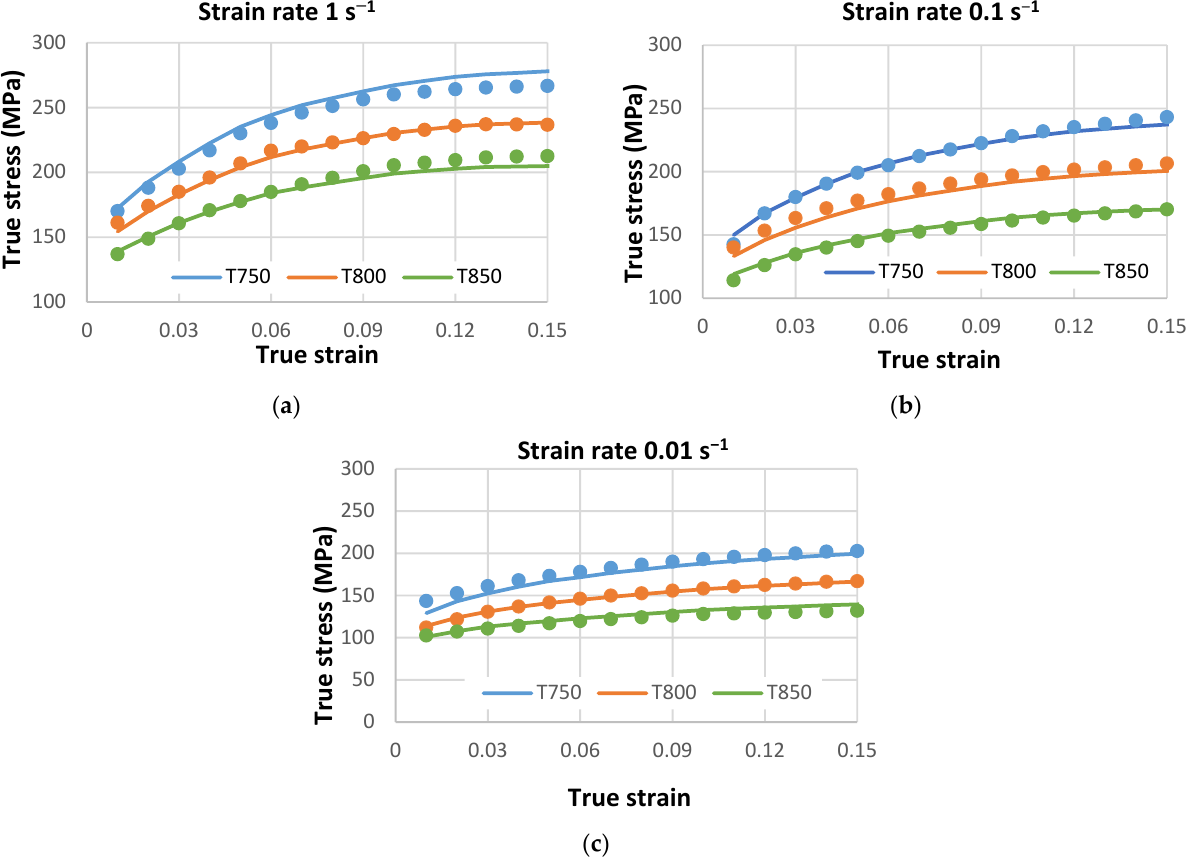
Figure 23. Comparison between experimental stress – strain curves (solid lines) and predicted stress – strain curves (circular markers) using the Arrhenius constitutive equation at various strain rates: ( a ) 1s −1 , ( b ) 0.1 s −1 , and ( c ) 0.01 s −1 for the USIBOR ® 2000.